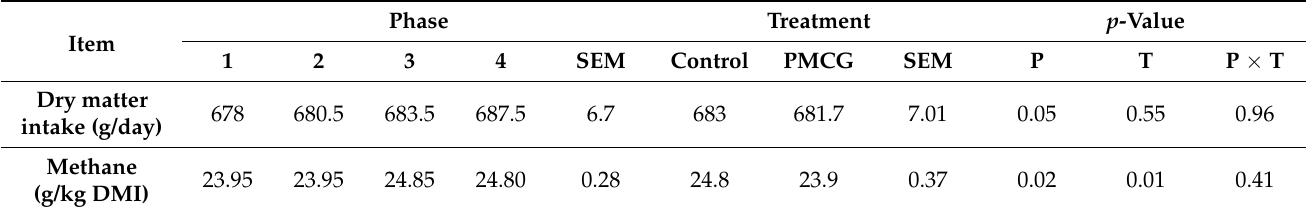
Table 3. Effects of PMCG on dry matter intake and methane emission of